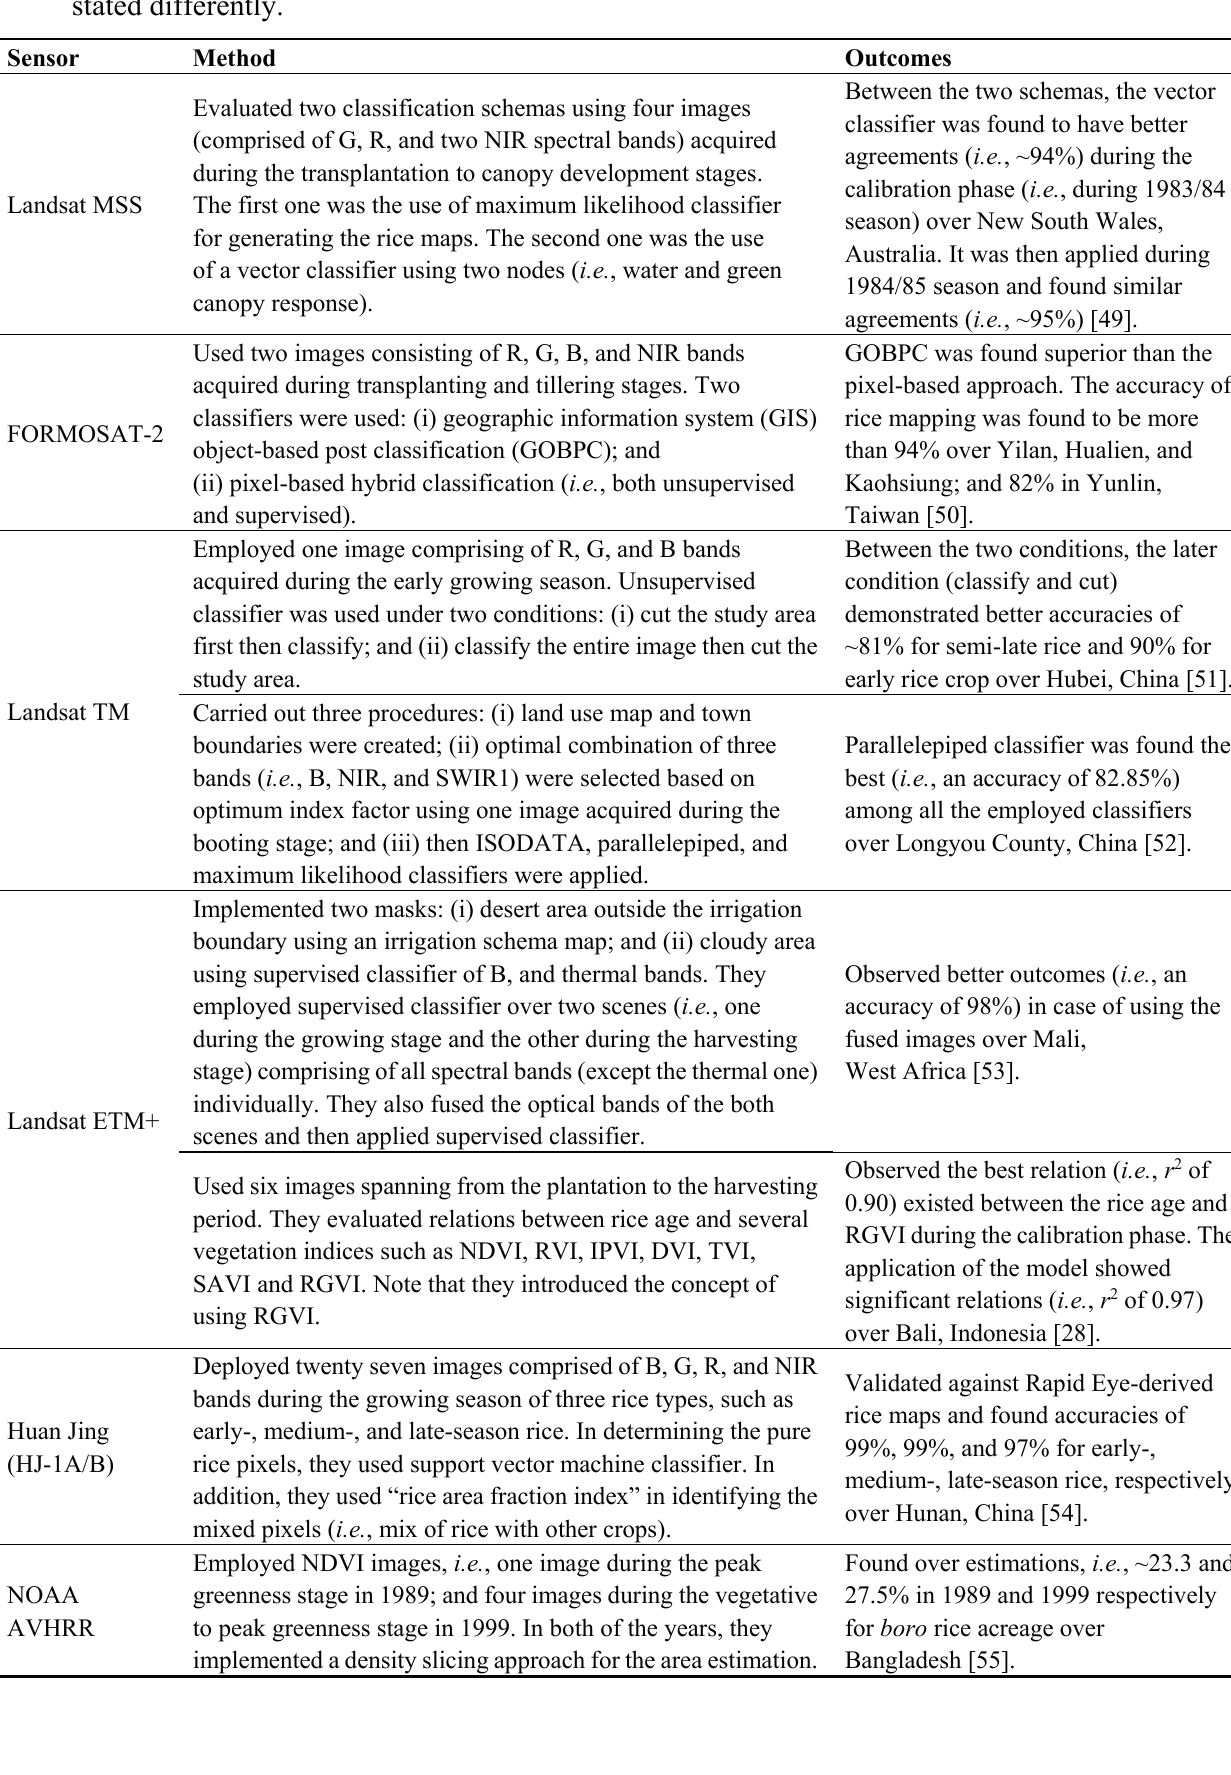
Table 2. Examples of optical remote sensing-based methods used for rice area mapping, which were usually evaluated against the agricultural statistical dataset unless stated